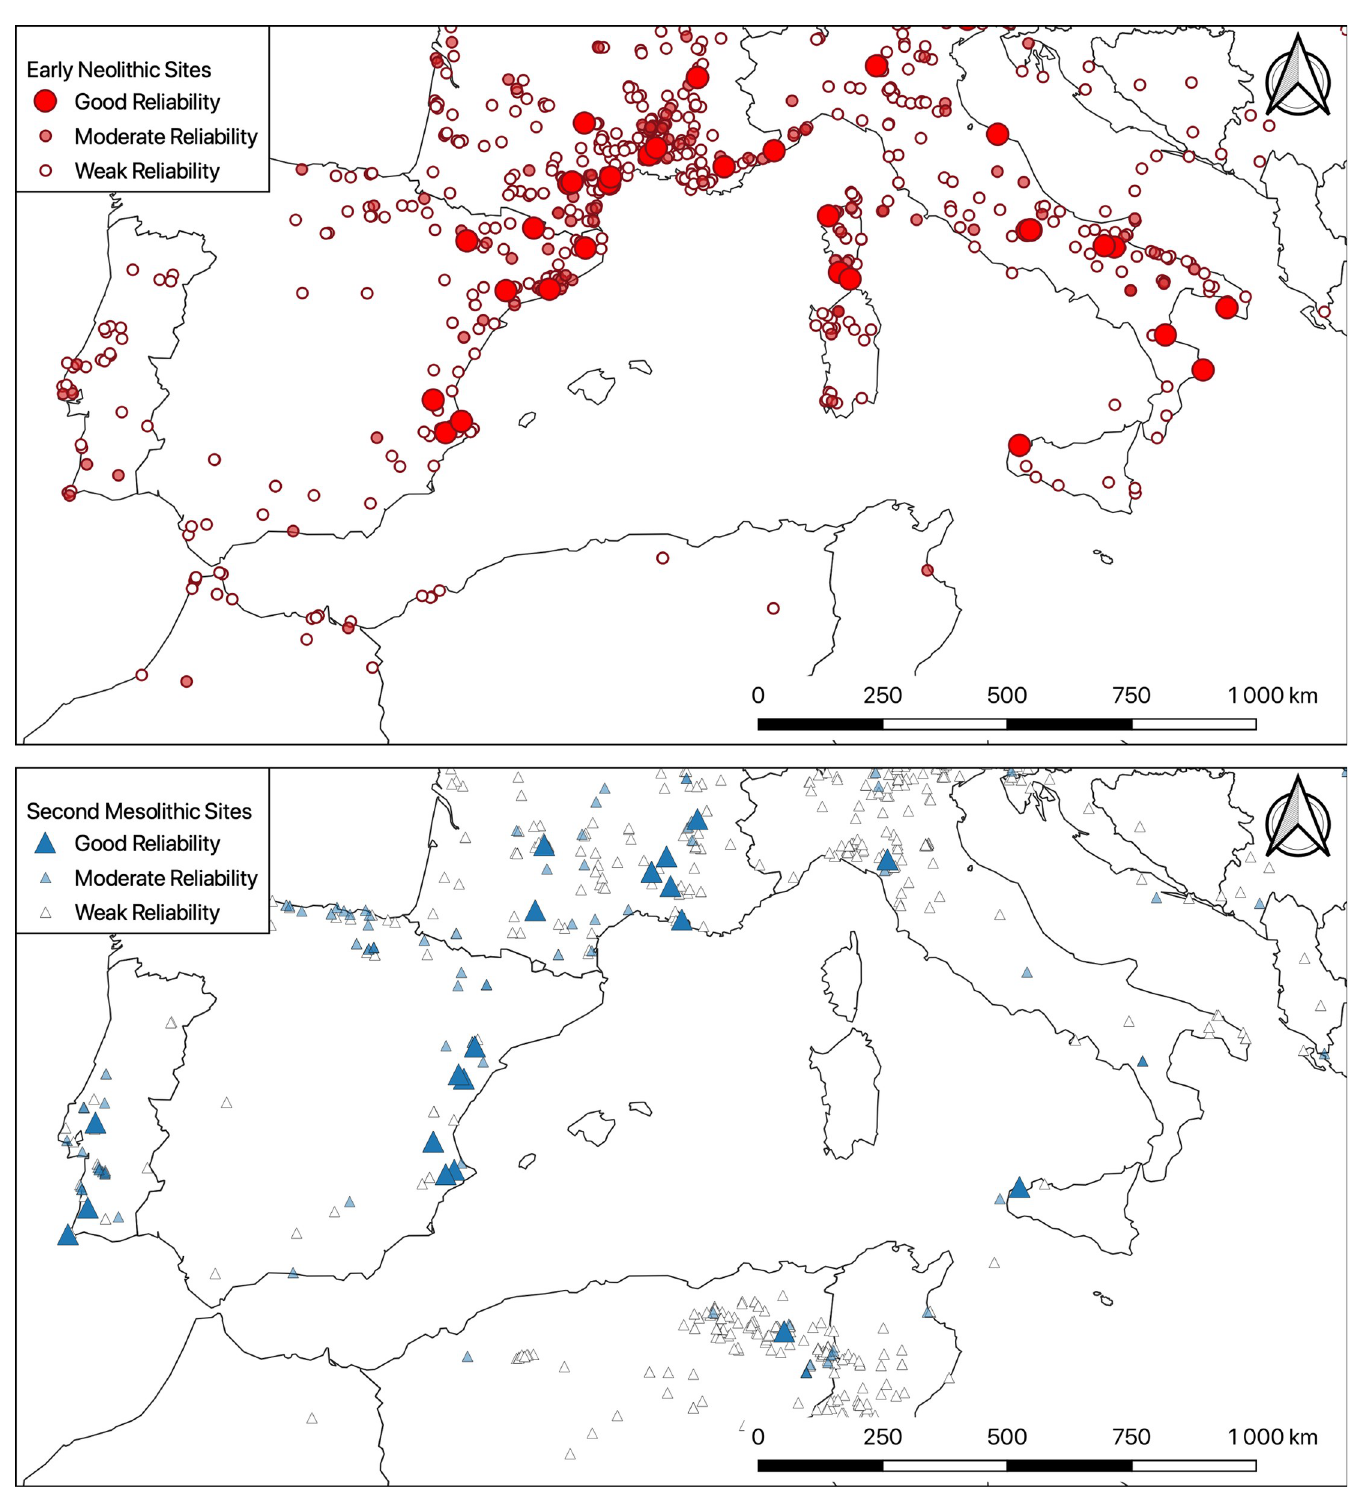
Fig 4. Distribution maps of the main second Mesolithic (after ~6,500 BCE) and early Neolithic occupations in the Western Mediterranean classified according to their reliability. Countries boundaries are from Natural Earth (free vector and raster map data @ naturalearthdata.com).